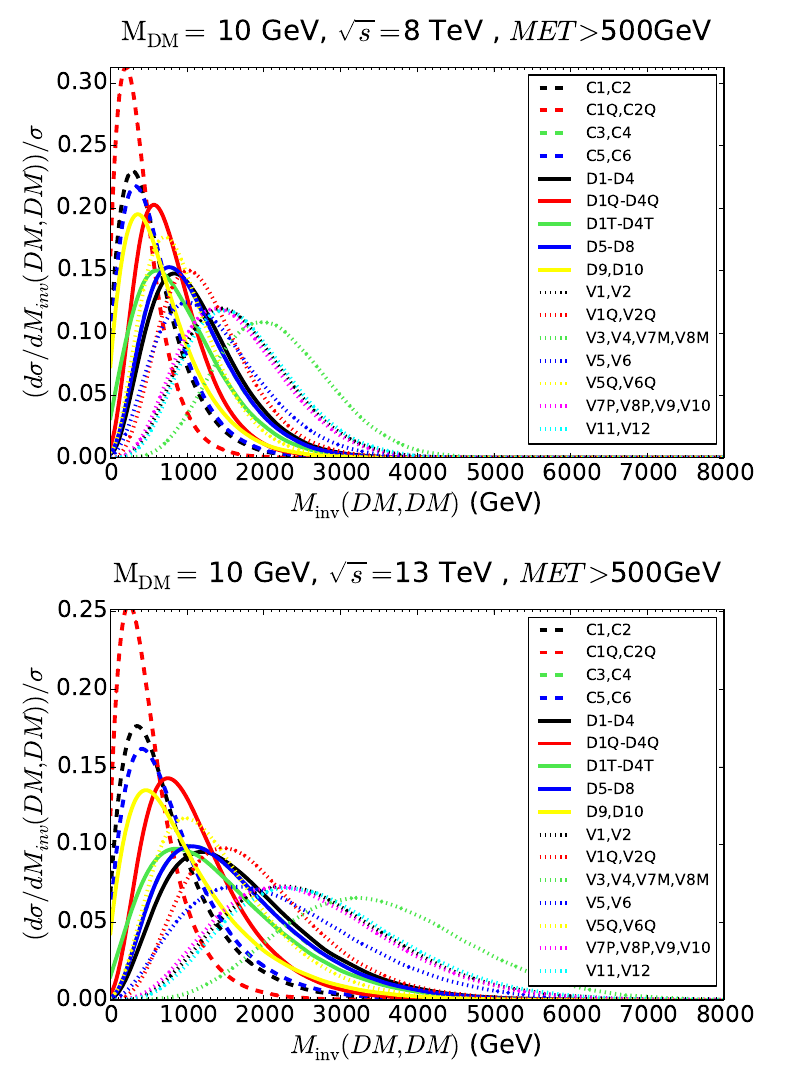
Figure 4 . Invariant mass of DM pair distributions normalised to unity for EFT operators listed in tables 1 and 2 for 8 TeV (top) and 13 TeV (bottom) LHC energy, M DM = 10 GeV and p T; jet (cid:21) 500 GeV cut